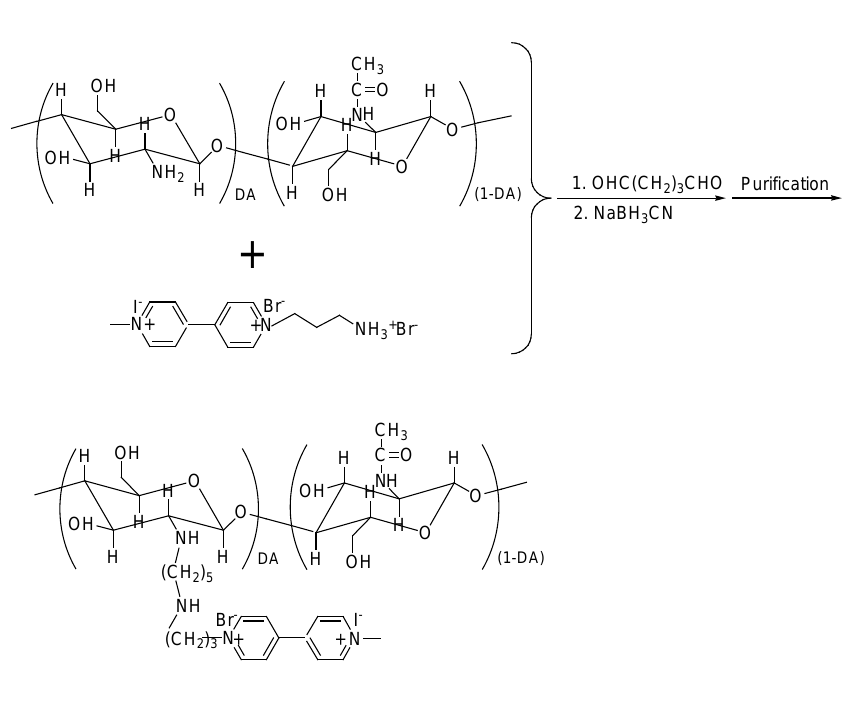
Figure 2. CHIT-V synthesis